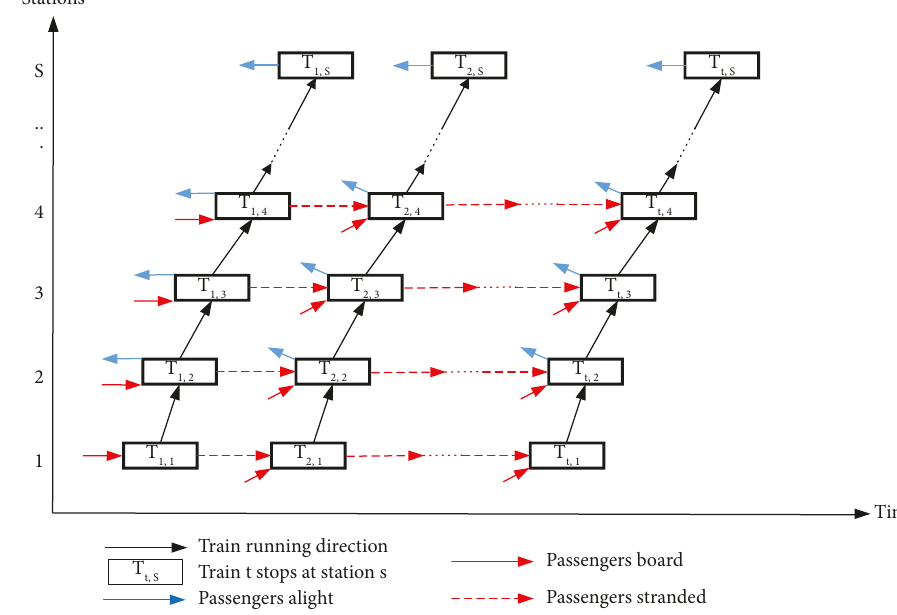
Figure 5: Schematic of passenger boarding and alighting interactions on the